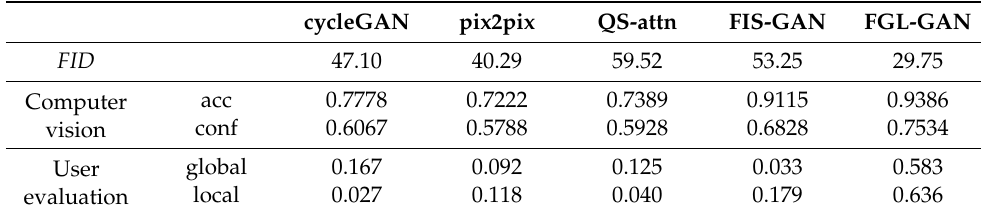
Table 1. Quantitative evaluation